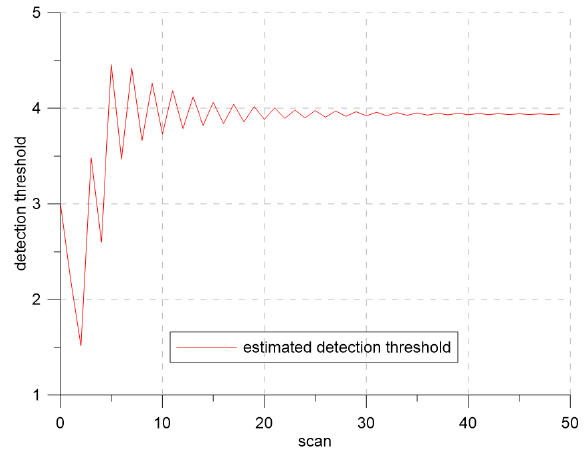
Figure 8. The detection threshold for λ = 1.2.